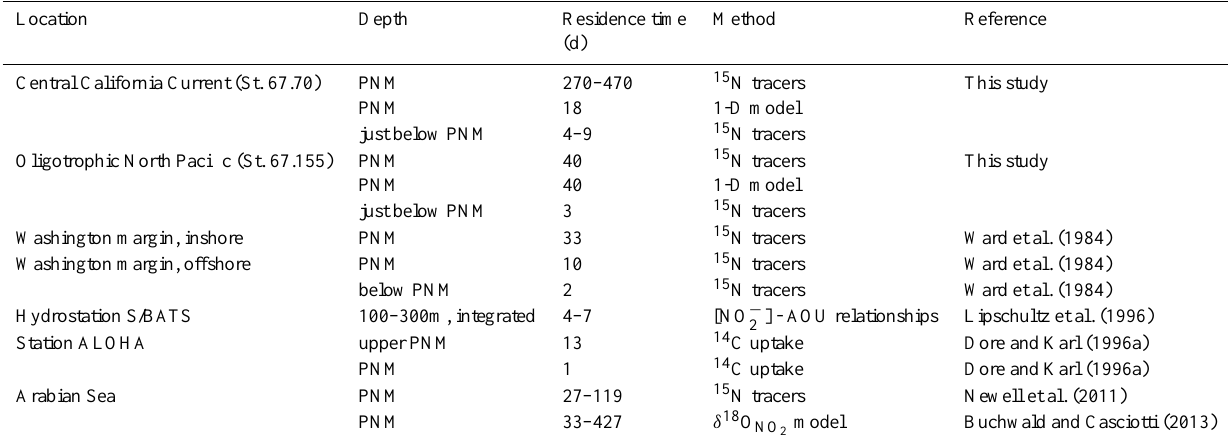
in the primary nitrite maximum (PNM). When residence time was not explicitly 2 ]/production rate. 2